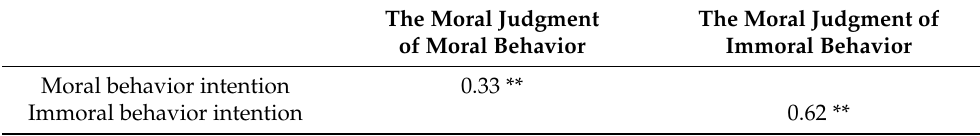
The Moral Judgment The Moral Judgment of of Moral Behavior Immoral Behavior